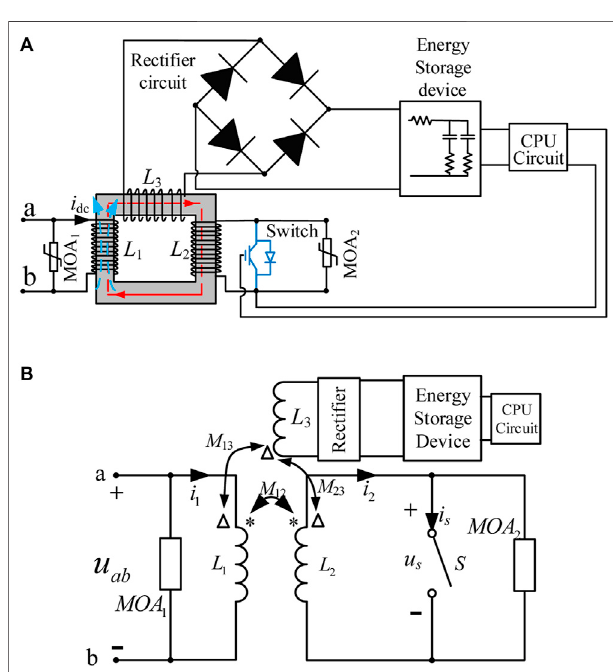
FIGURE 2 | Structure of the TTSSFCL with SPSS. (A) Con fi guration of the TTSSFCL with SPSS. (B) Equivalent circuit of the TTSSFCL with SPSS.